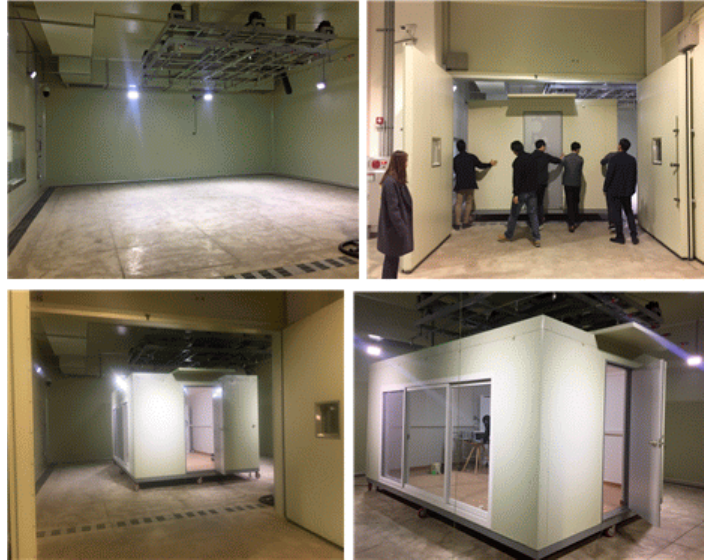
Figure 17. View of RCEC and installation of inner chamber for experiment.